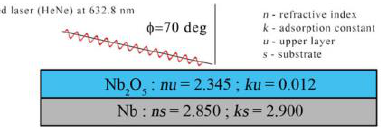
Figure 2. Niobium oxide model for ellipsometric measurements.